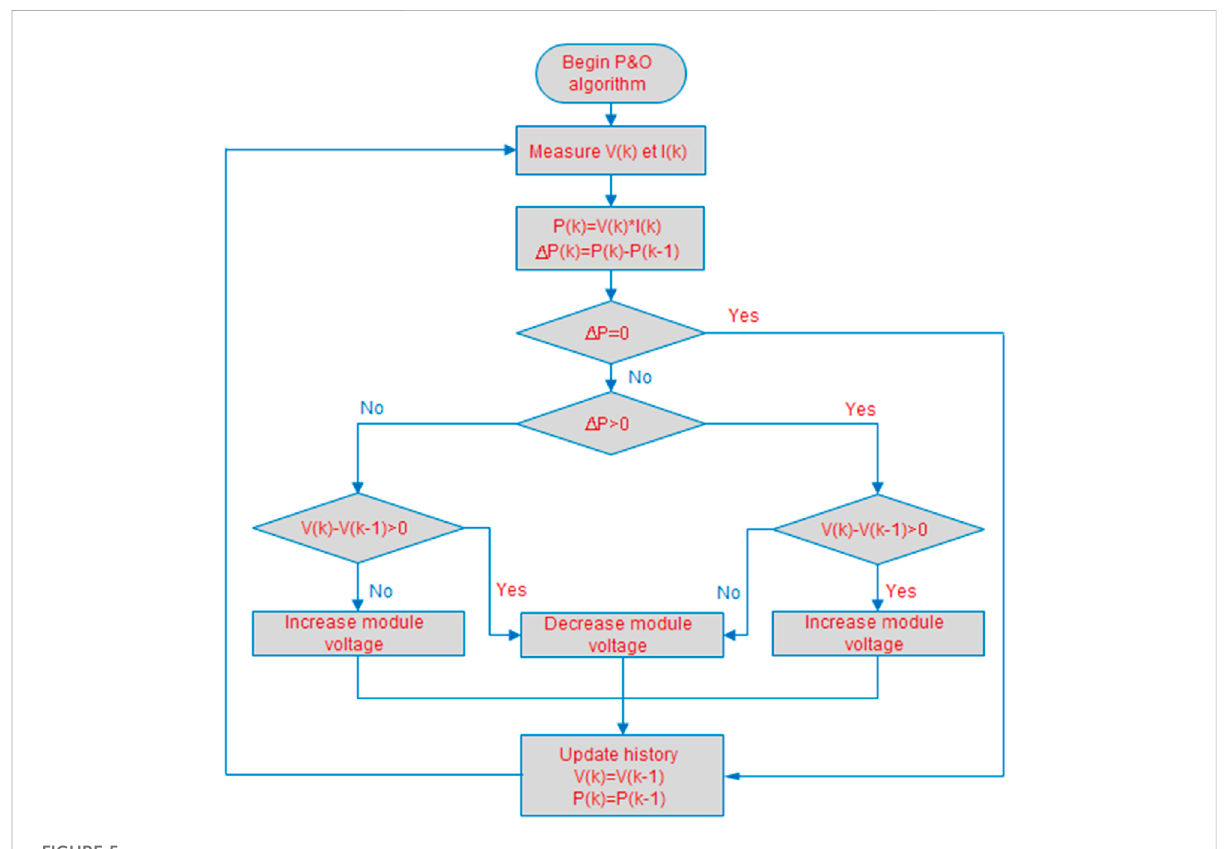
FIGURE 5 Flowchart of the P&O algorithm.